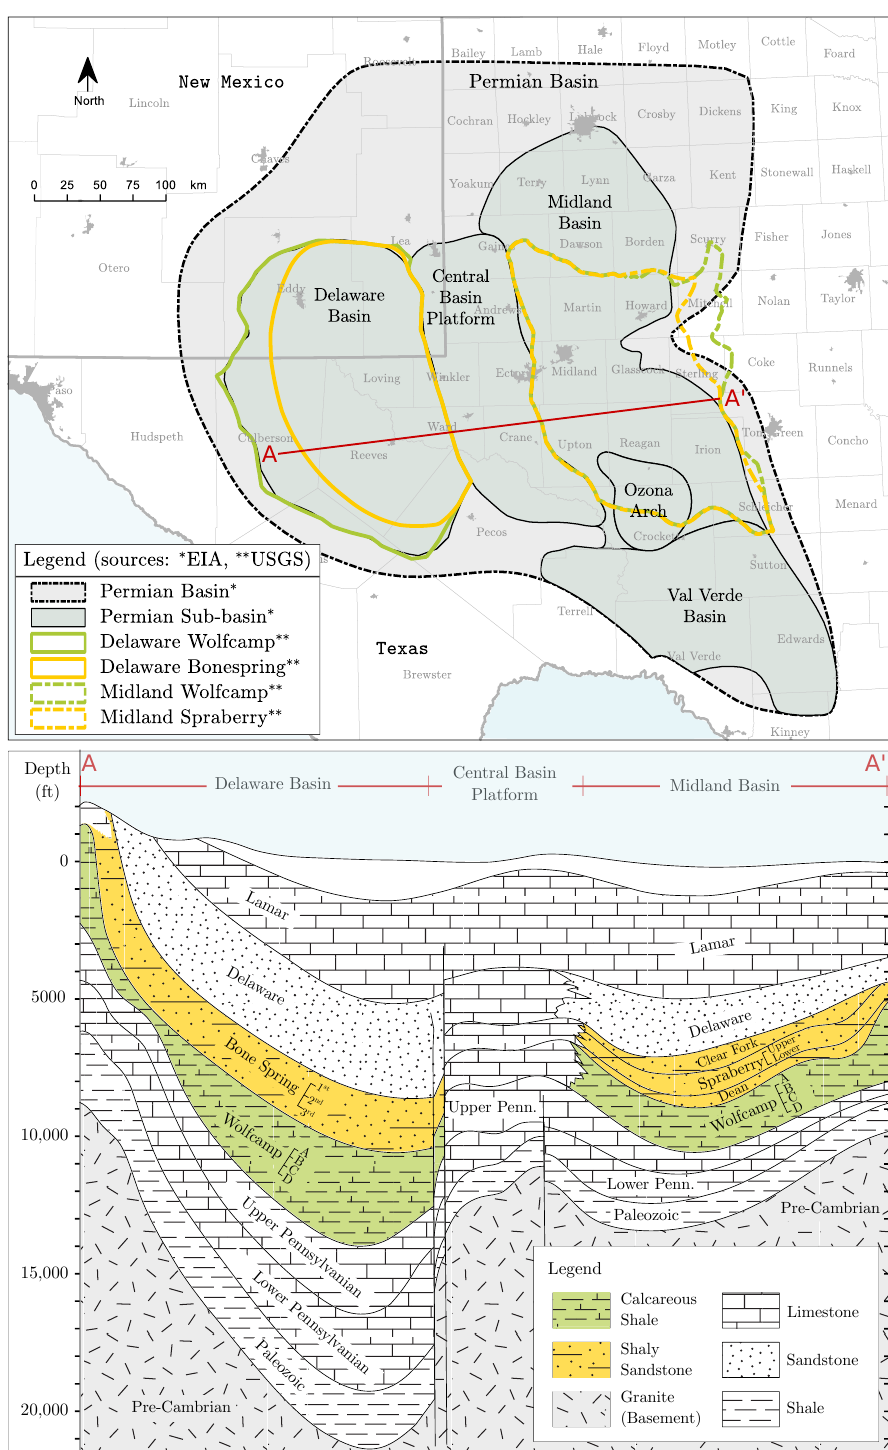
Figure 1. Aerial extents and cross-section of Permian Basin, sub-basins, and the most prolific produc- ing tight formations: Wolfcamp, Bonespring and Spraberry. Data sources: EIA [21] and USGS [6]. In Figure 2, we plot the maximum daily oil rates from the four major sub-regions of the Permian: (1) Delaware Bonespring; (2) Midland Spraberry; (3) Delaware Wolfcamp; and (4) Midland Wolfcamp. A Core area is an area that envelopes all best producing wells with the maximum daily oil rates of more than 750 bbl/d. We define each Noncore area as the difference between the core area and the formation extent defined by